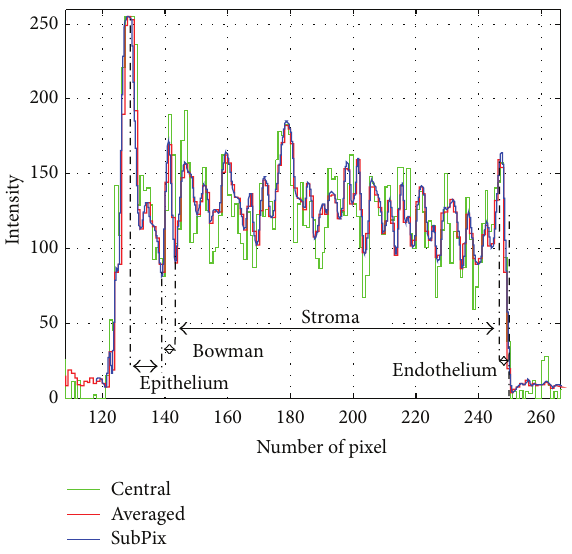
Figure 5: Pixel intensity profile on a 25 pixels wide slice, centred on the corneal apex. In green the intensity of the only axial column is represented, while in red and blue, the averaged intensities in pixel and subpixel elaborations,